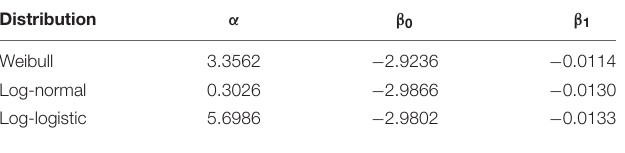
TABLE 1 | Distribution parameters for Weibull, log-normal, and log-logistic distributions.